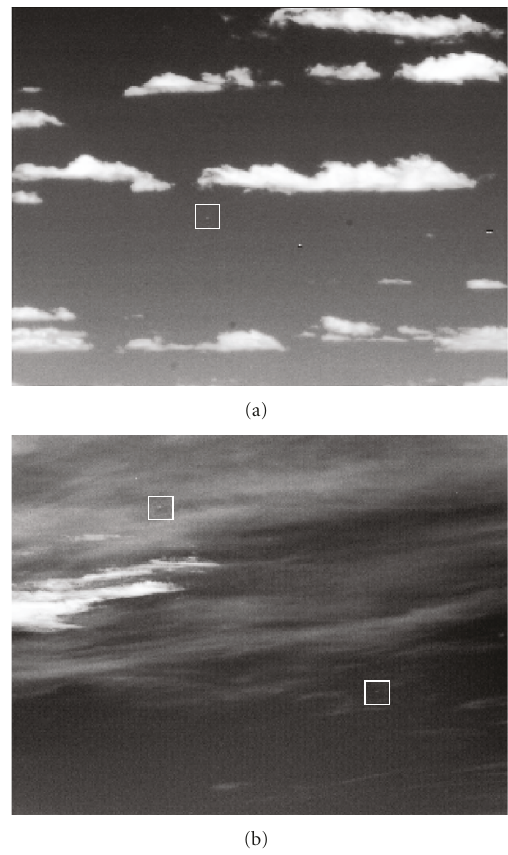
Figure 7: A single frame from IR sequences. (a) NA23A and (b) NPA sequence showing the target’s locations (white